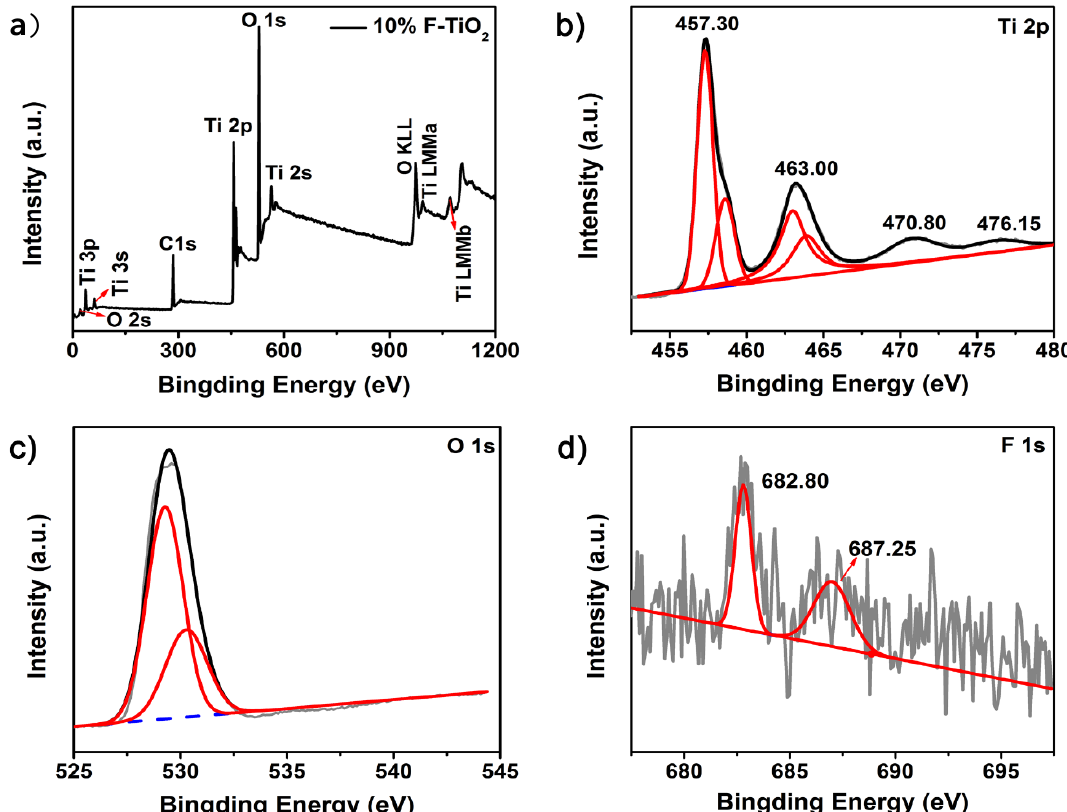
Figure 6. ( a ) Survey XPS spectrum of 10% F–TiO 2 nanosheets; High-resolution XPS spectra of ( b ) Ti 2p; ( c ) O 1s and ( d ) F 1s regions for the 10% F–TiO 2 nanosheets. The gray lines are original curves, and the red, black lines are the fitting curves.